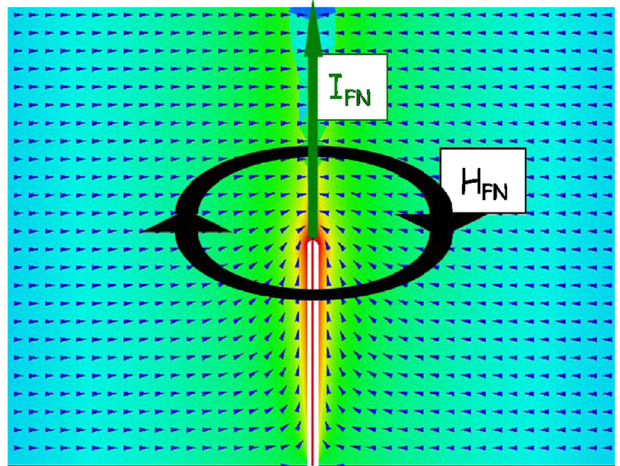
FIG. 9. (Color) Schematic view of the power flow balance near the tip.FIG. 7. (Color) Field emission power flow distribution near the